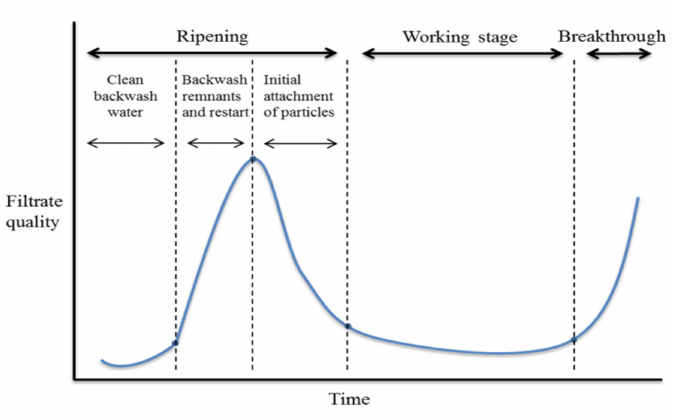
Figure 2. The filter cycle (reprepared using the data from